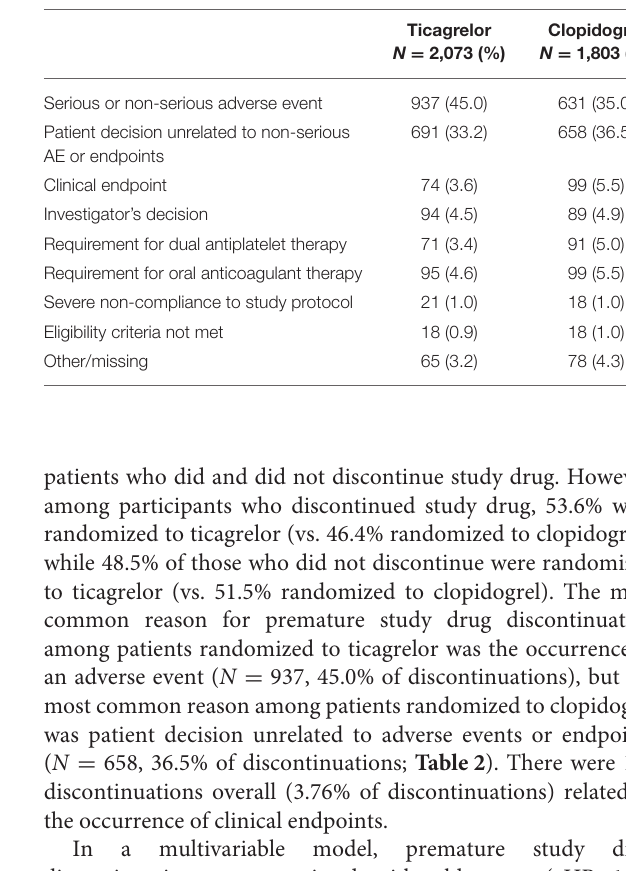
TABLE 2 | Reasons for premature, permanent study drug